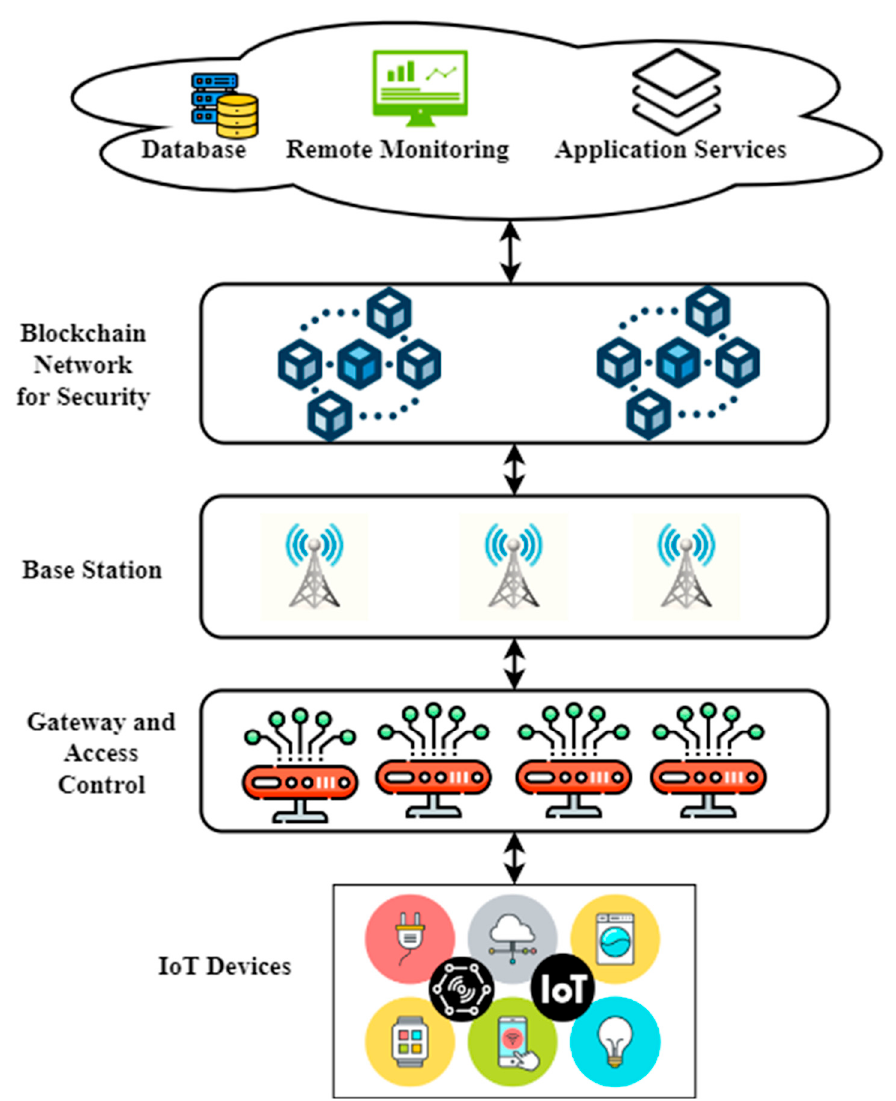
Figure 1. Proposed ACE-BC framework.